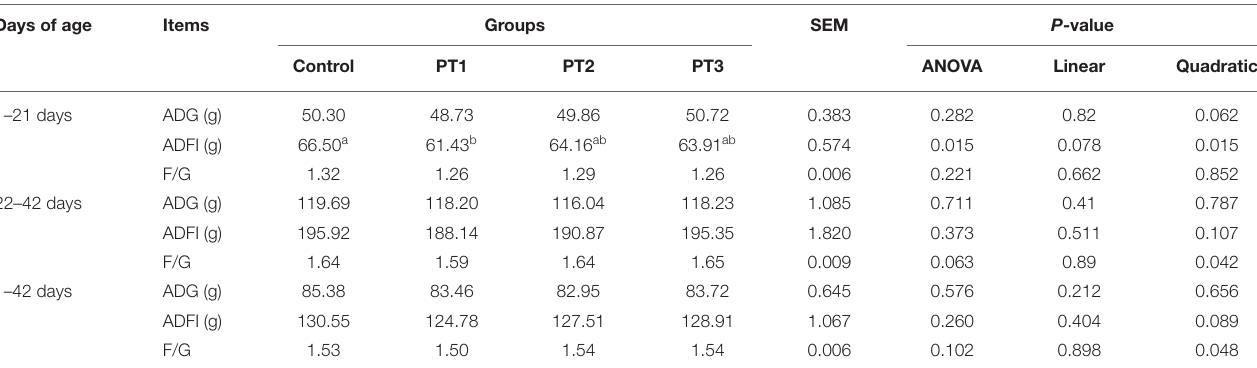
TABLE 2 | Effects of Plotytarya strohilacea Sieb. et Zuce tannin on broilers growth performance. Days of